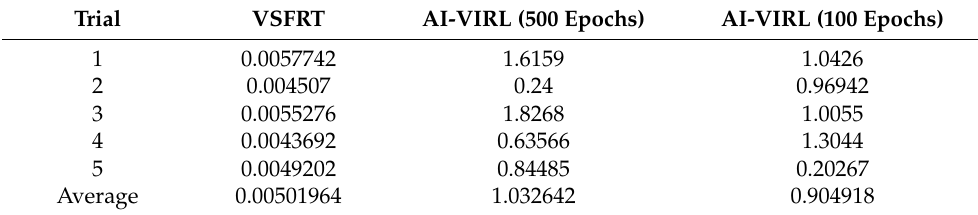
Table 4. VSFRT and AI-VIRL tracking performance when learning uses open-loop IO data. Trial VSFRT AI-VIRL (500 Epochs) AI-VIRL (100 Epochs)